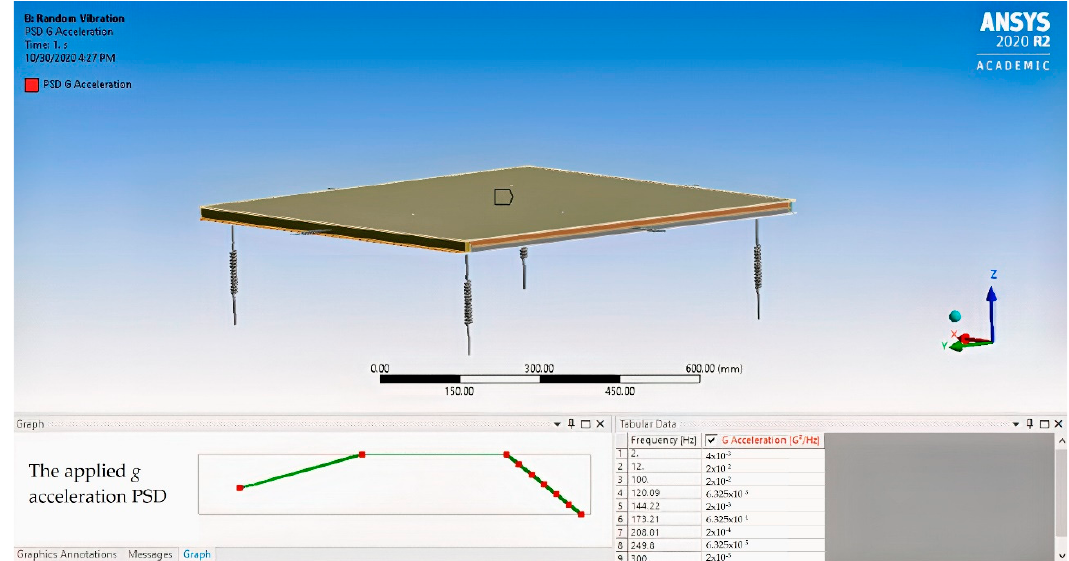
Figure 17. The model and the applied g acceleration PSD with assurance level 1.